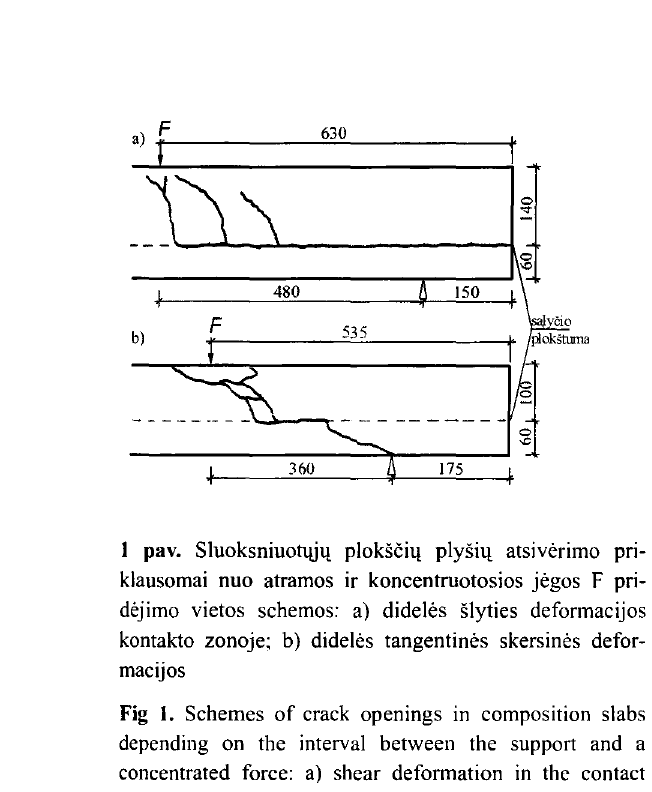
Fig I. Schemes of crack openings in composition slabs depending on the interval between the support and a concentrated force: a) shear deformation in the contact zone; b) long plate shear deformations